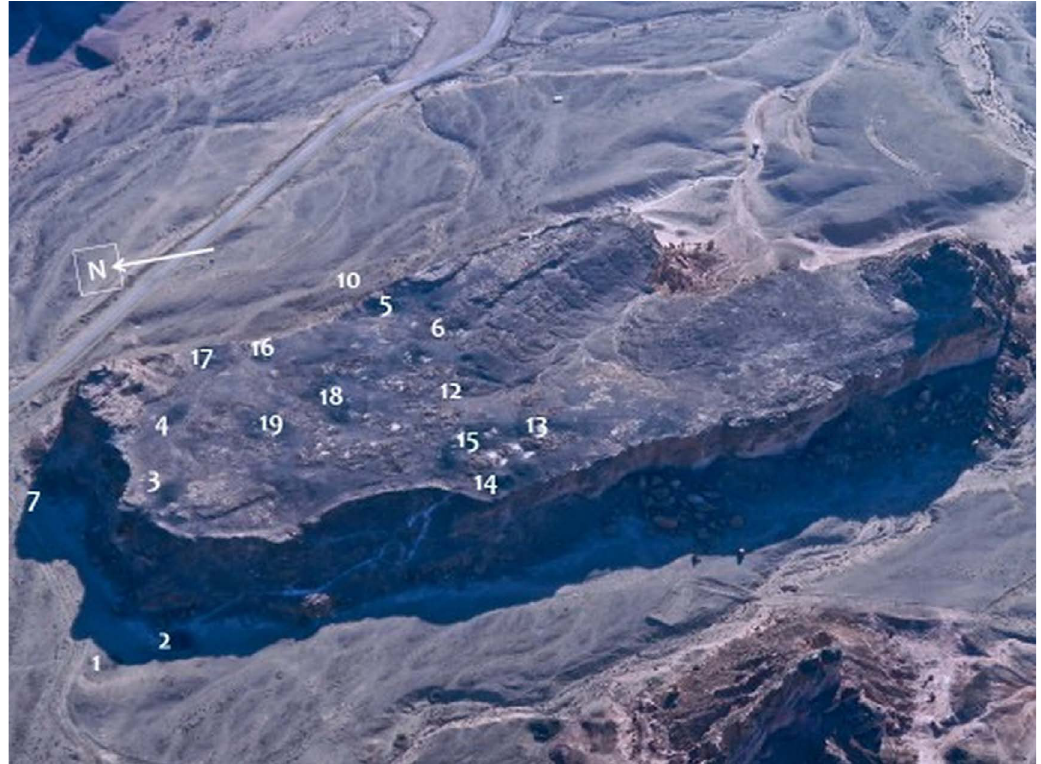
Figure 3. Major slag mounds at Site 34 (Slaves’ Hill) and its surroundings; the hilltop from north to south is approximately 300